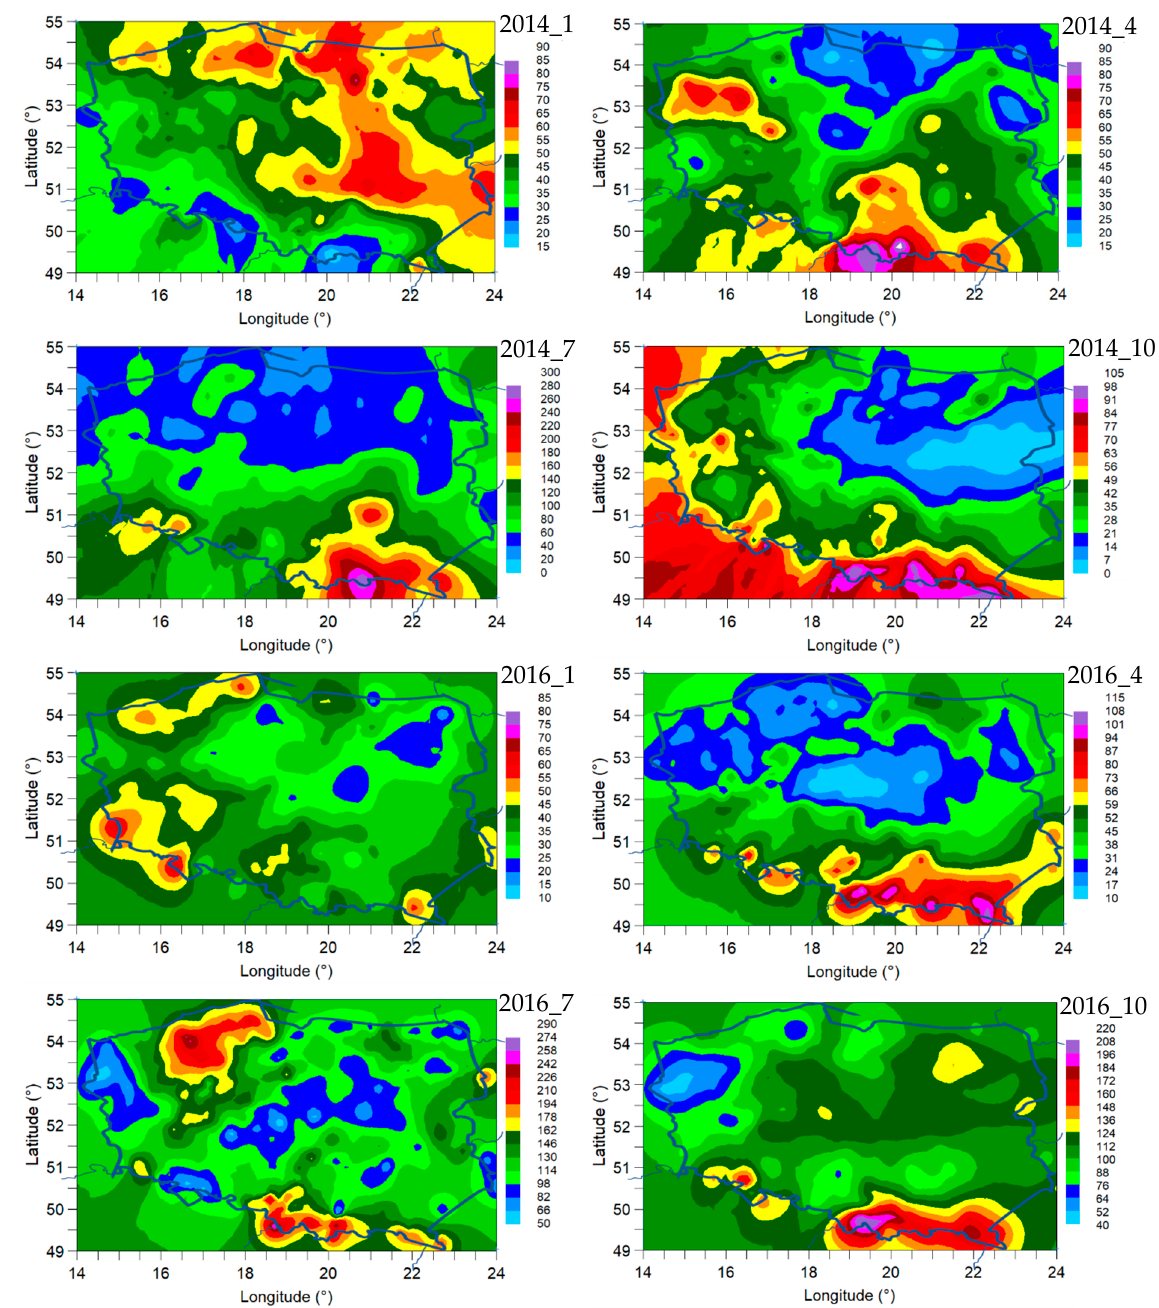
Figure 3. cont. Spatial distribution of monthly rainfall (2D maps) in Poland estimated by the ordinary cokriging interpolation method for selected months in 2014 and 2016 year. (1° = approx. 100 km). Maps were created using Gamma Design Software GS+10 [60].